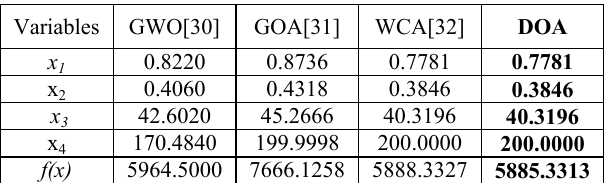
Table 1. Comparison of results for the pressure